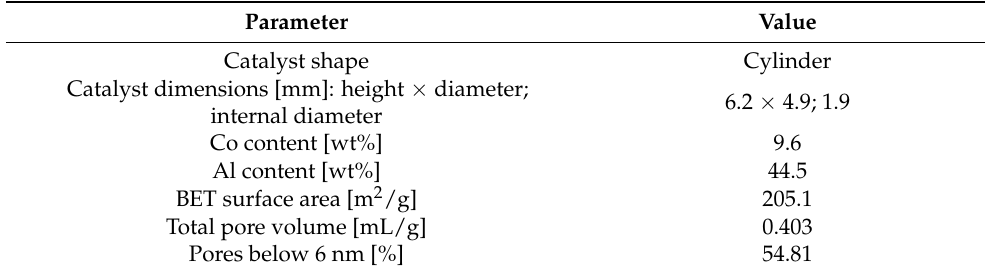
Table 8. Fresh Co-based catalyst prepared with non-calcined support impregnated in a 20 wt% solution description, XRF analysis and BET analysis results.